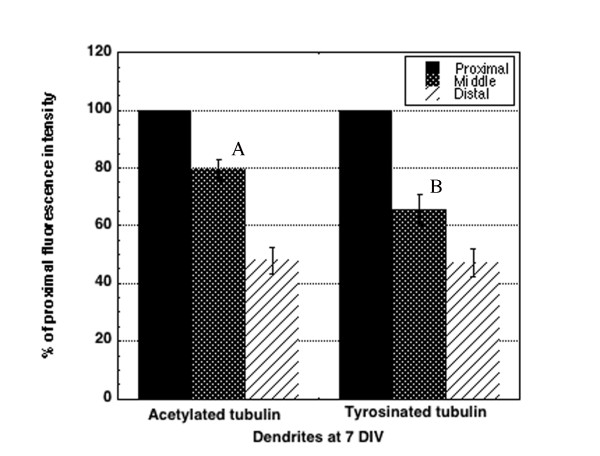
Dynamic microtubules remain high in dendrites at 7 DIV. Comparison of immunofluorescence intensity in the mid- and distal dendritic shaft of neurons at 7 DIV shows both Ac-tubulin and Tyr-tubulin decline as the dendrites taper. At the mid-shaft, Tyr-tubulin is about 65% of its original intensity at the origination of the dendrite from the soma, whereas Ac-tubulin has decreased to 78%. These values are significantly different from each other (distinguished by different letters, A versus B, P < 0.05). Both Ac and Tyr have decreased to about 48% of the original intensity in distal regions (excluding the last 10 μm of distal tip/growth cone region). Error bars represent standard error of the mean.